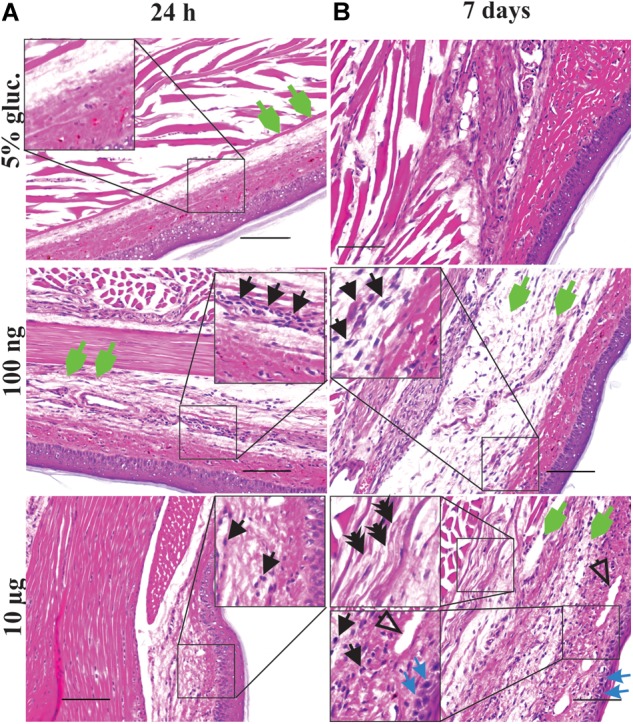
Local vincristine administration leads to infiltration of leukocytes. Representative pictures (H&E staining) showing histopathological changes of the epidermis, dermis, hypodermis and adjacent areas of the plantar glabrous skin of the injected hind paw after administration of vincristine (i.pl.,10 μg or 100 ng vincristine) or vehicle (i.pl., 5% glucose) after 24 h (A) or 7 days (B). Injections were performed as indicated in Figure 1. Magnification 200 x; scale bar (100 μm). Black arrow, leukocytes; open arrow, arteriolar necrosis; green arrow, edema; blue arrow, dermal necrosis; double arrow, nerve vacuolization.